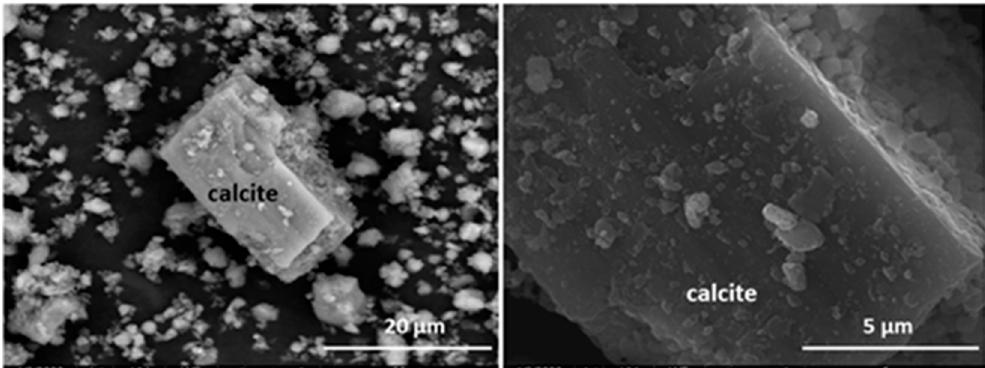
Figure 3. Microaggregates and surface deposits on rhombohedral calcite crystal ( left ). Detail of initial HcV waste surface ( right ).